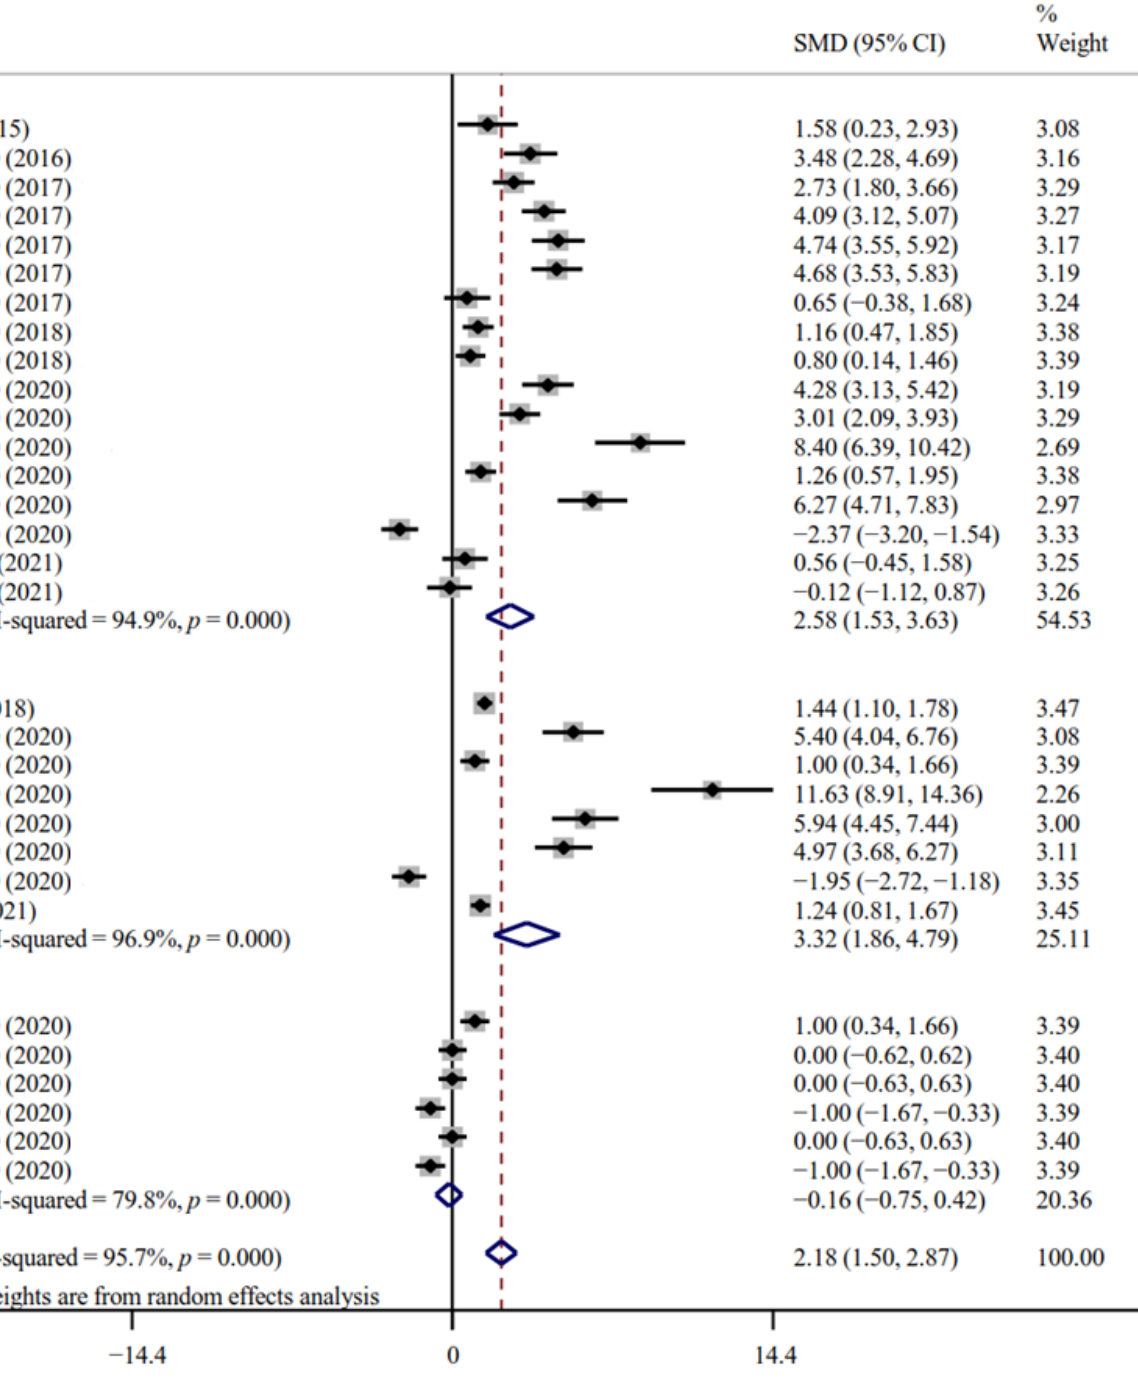
Figure 5. Forest plots assessing the effects of NM exposure on the level of MDA in different samples compared with the non-exposed control group. NMs, nanomaterials; EBC, exhaled breath condensate; MDA, malonaldehyde; SMD, standardized mean difference; CI, confidence interval [15,18,19,31,33,34,41,43,45].